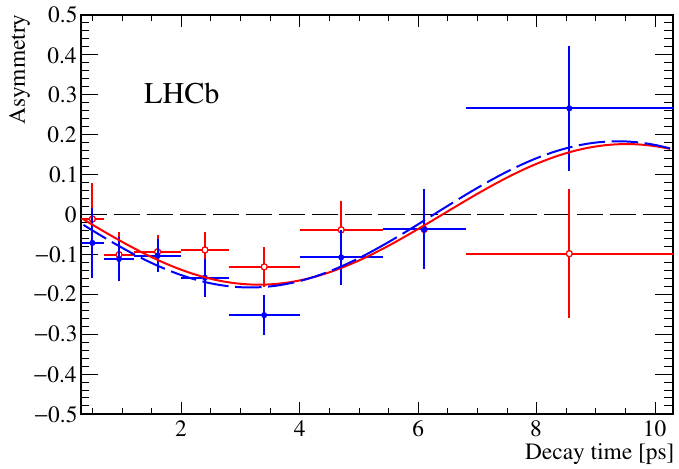
Figure 3 . Asymmetry between B 0 and B 0 signal yields as a function of the decay time, for (blue full dot) D (cid:3) + D (cid:0) and (red empty dot) D (cid:3)(cid:0) D + signal candidates with a non null tagging decision. The background contribution is subtracted by means of the sPlot technique. The corresponding projections of the PDF are represented by the blue dashed (red continuous) line. The B 0 (cid:13)avour is determined by the combination of all (cid:13)avour-tagging